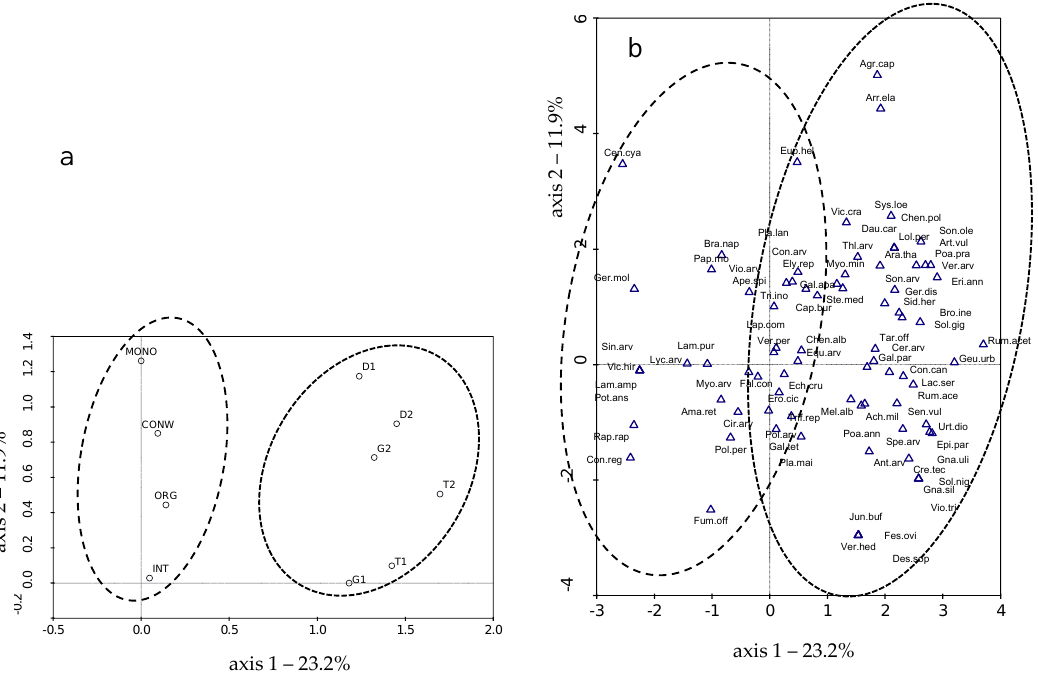
Figure 10. Ordination diagram of objects ( a ) and species ( b ) in relation to the first and second axis of